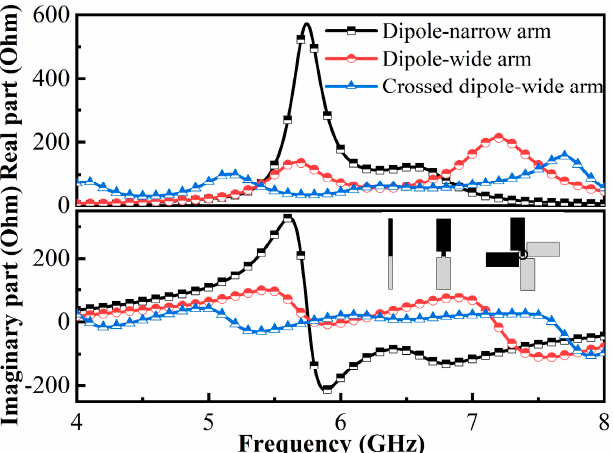
Figure 1. Simulated input impedances of three different dipoles. The thumbnail shows the struc ‐ ture of a dipole with a narrow arm, a dipole with a wide arm, and the crossed dipole, in order.